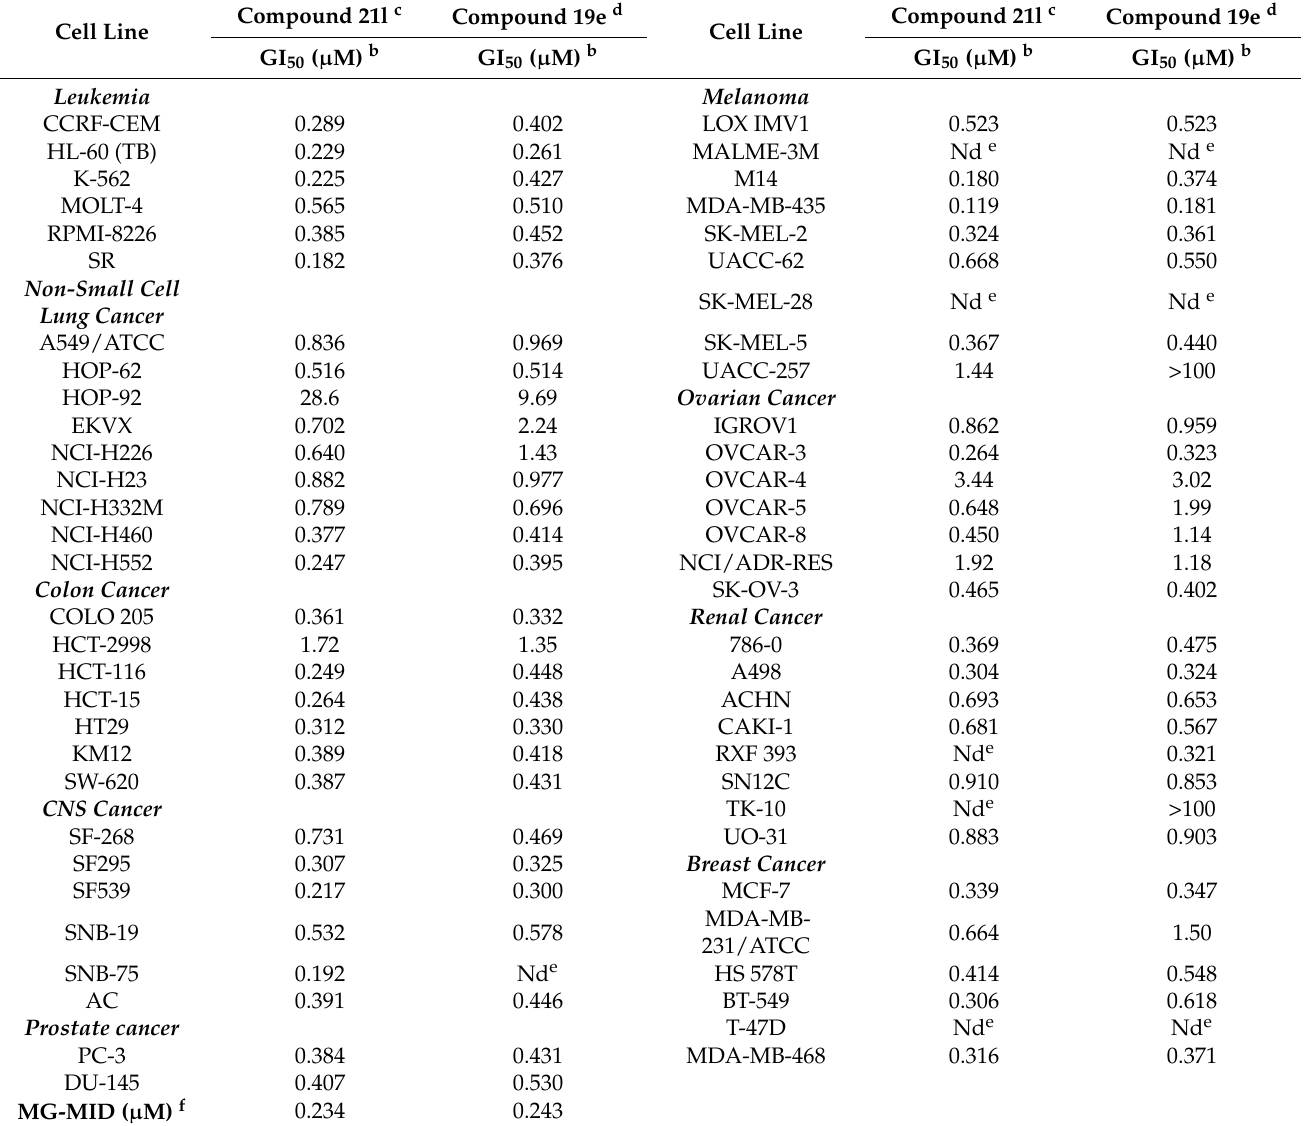
Table 3. Antiproliferative evaluation of compounds 21l and 19e in the NCI 60 cell line in vitro screen a .